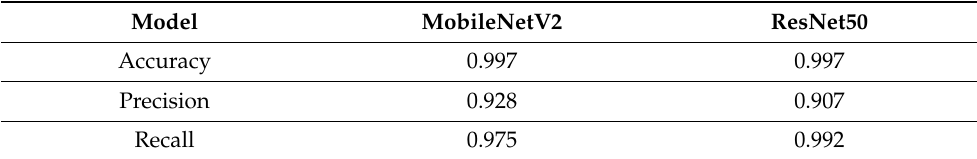
Table 3. Classification performances: Deep learning approaches.